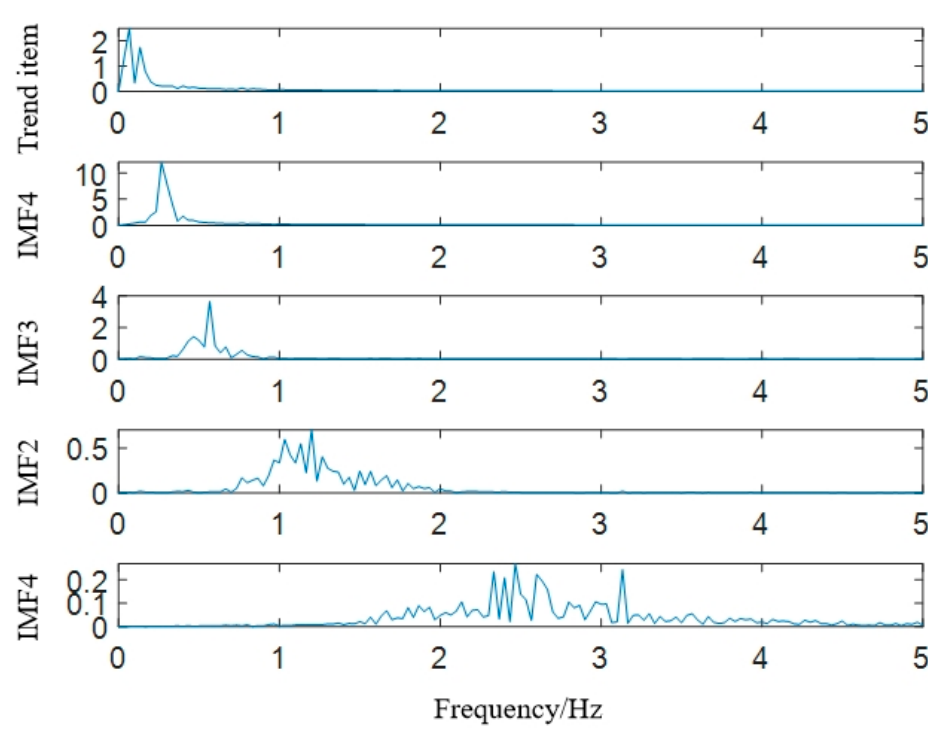
Figure 6. Spectrum of IMFs.